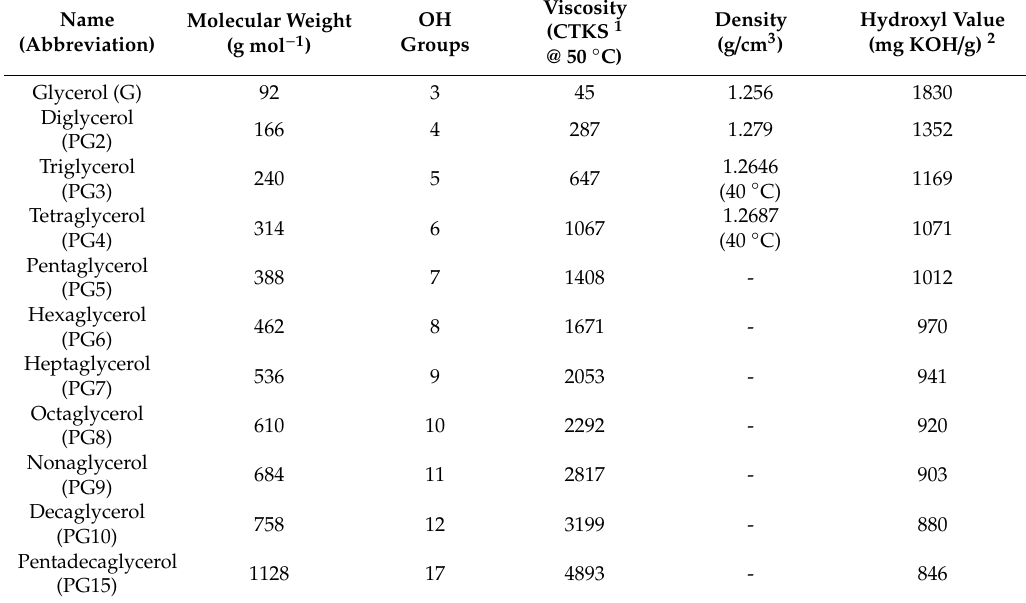
Table 1. Properties of linear polyglycerols commonly available on the market